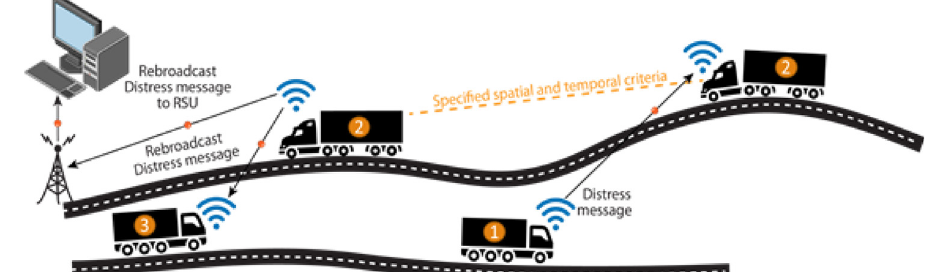
Figure 5 DN concept diagram (Gopalakrishna et al. ,